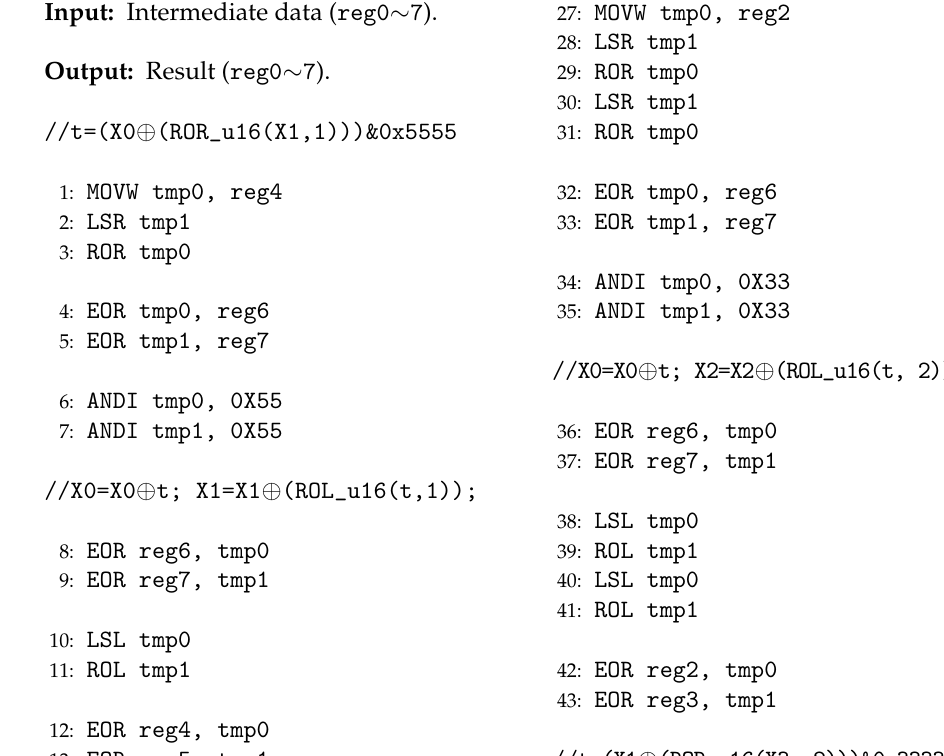
Algorithm 2: Permutation ( P 0) operation in assembly